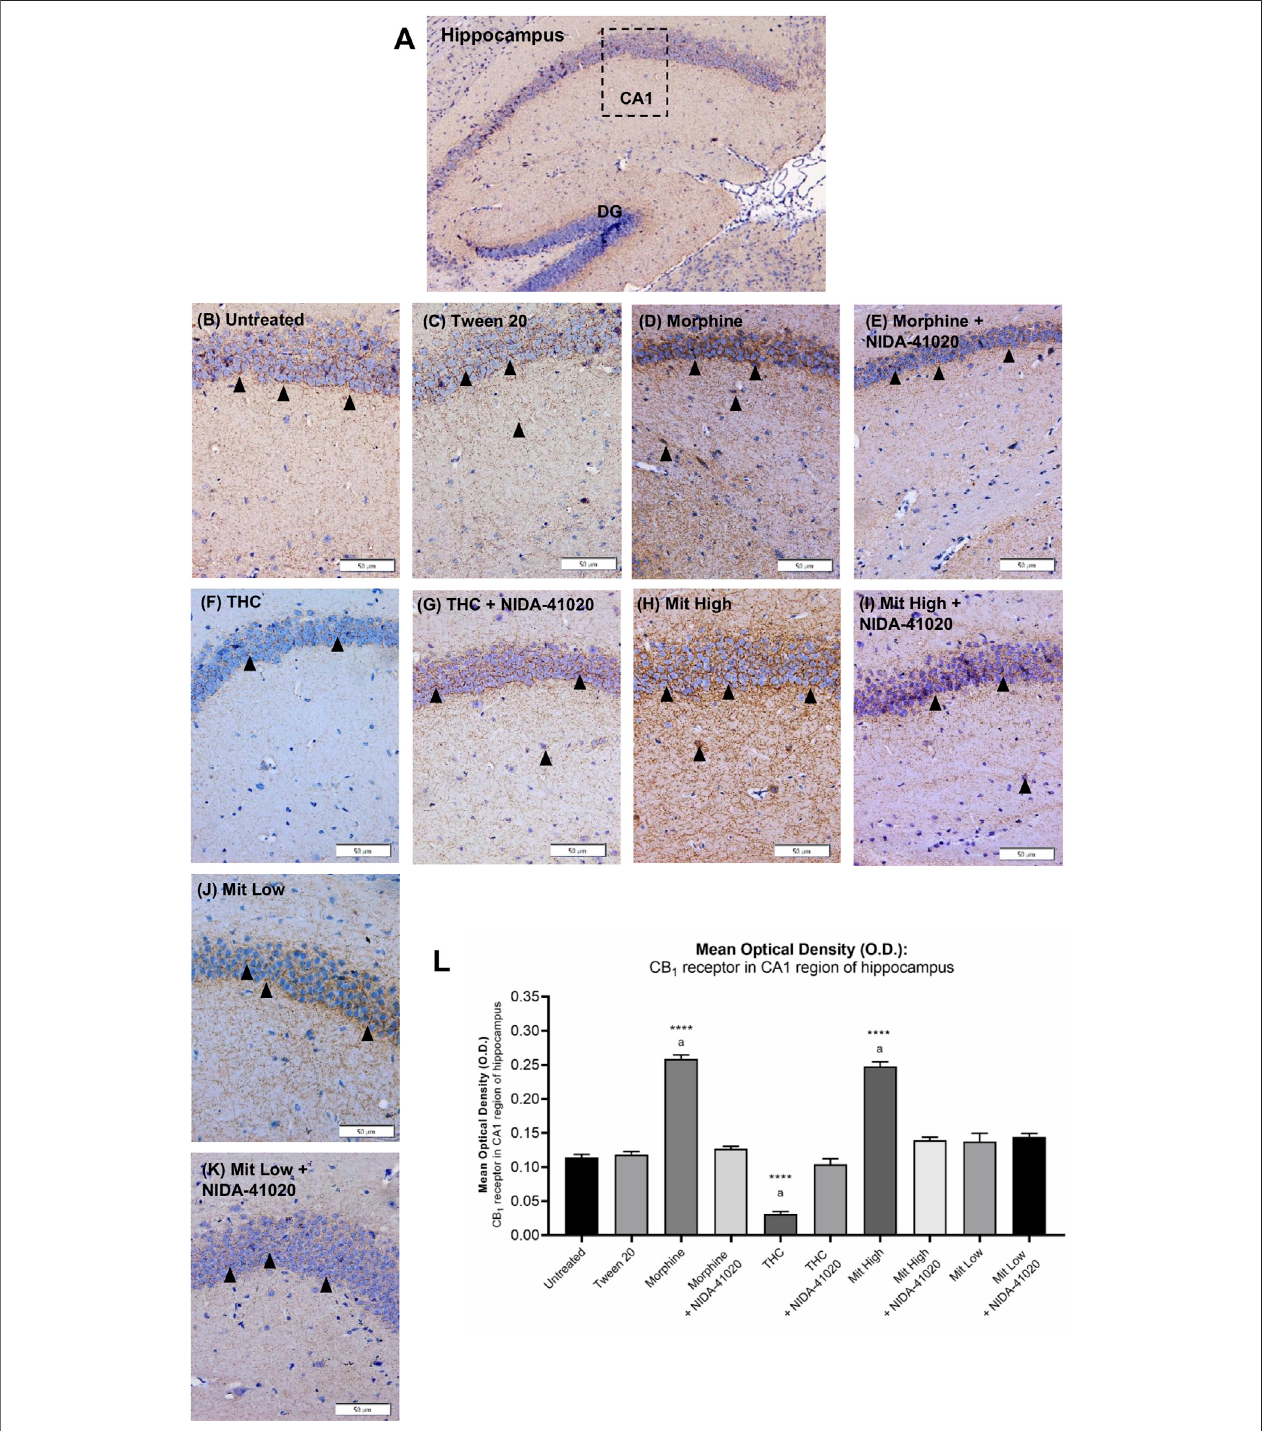
FIGURE 6 | Effects of drug intervention on CB 1 receptor staining in the (A) CA1 pyramidal region ofthe mice hippocampus ( × 100 magni fi cation). The micrographs represent (B) untreated, (C) Tween 20, (D) morphine, (E) morphine + NIDA-41020, (F) THC, (G) THC + NIDA-41020, (H) high-dose mitragynine, (I) high-dose mitragynine + NIDA-41020, (J) low-dose mitragynine, and (K) low-dose mitragynine + NIDA-41020 groups at × 400 magni fi cation. Arrowheads indicate CA1 pyramidal neurons surrounded by dense plexus ofCB 1 receptor immunoreactive fi bers. (L) Densitometric analysis are shown as the mean + SEM of15 replicates per group. **** p < 0.0001 vs Tween 20; a: p < 0.05 vs drug + NIDA-41020 groups (one-way ANOVA followed by post-hoc Tukey test). Bars (cid:1) 50 µm.